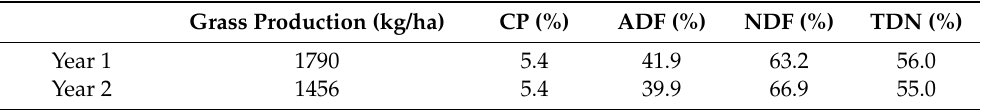
Table 1. Average yearly grass available biomass (kg DM · ha − 1 ), crude protein (CP% DM), acid detergent fiber (ADF %), neutral detergent fiber (NDF %), and total digestible nutrients (TDN %) of the experimental pasture for the 2 years of grazing (2018/2019 and 2019/2020) at the Northern Agricultural Research Center Thackeray Ranch, Havre, MT, USA.